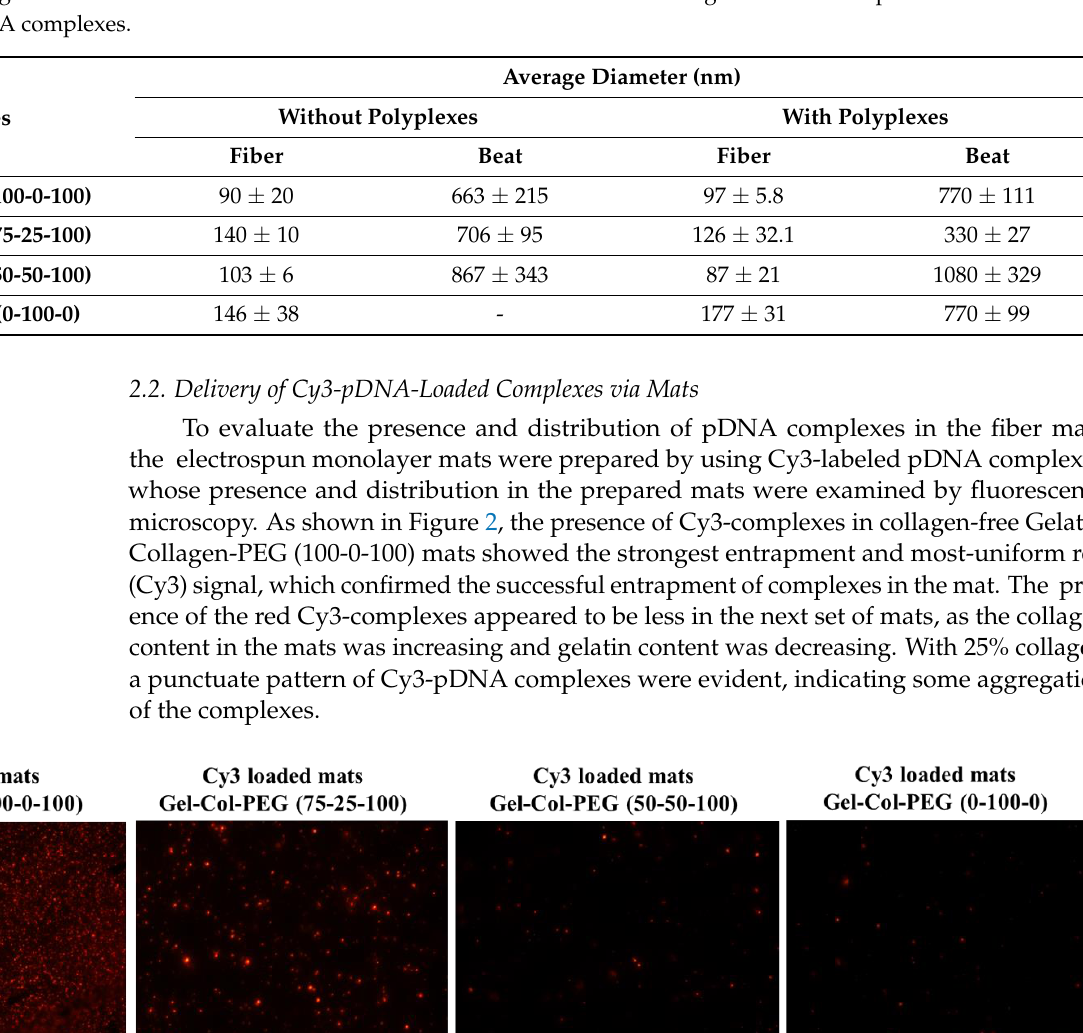
Table 1. Average fiber diameter and bead size of different volume ratio Gelatin-Collagen-PEG electrospun mats without and with pDNA complexes.